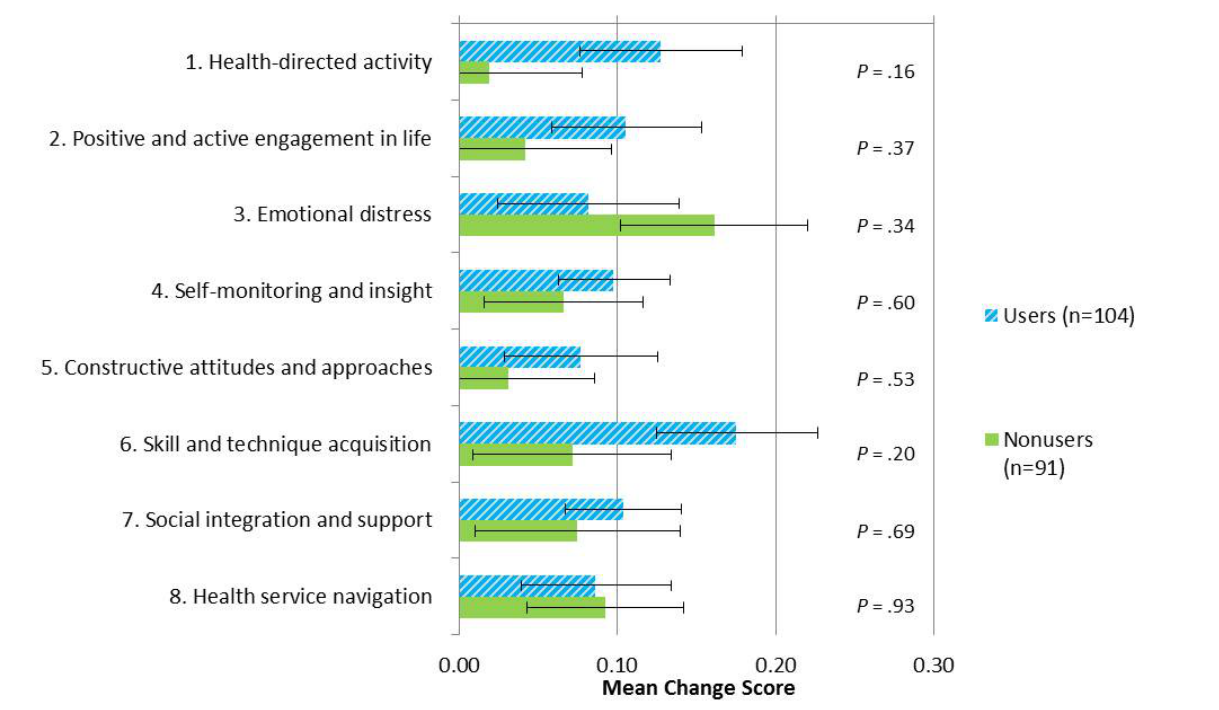
Figure 1. Mean change scores (standard error) between users and nonusers of the My Joint Pain website over a 12-month period for each Health Evaluation Impact Questionnaire